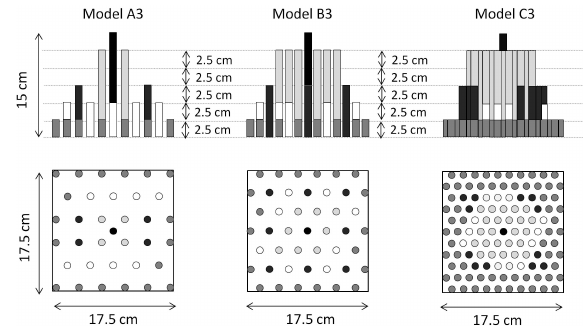
Fig. A2. Construction details of parameterized models of medium frontal area (models A3, B3, C3) at a scale of 1 : 20. Diameter of the cylinders representing mangrove roots is 1.0cm, diameter of cylinder representing a trunk is 1.0cm.